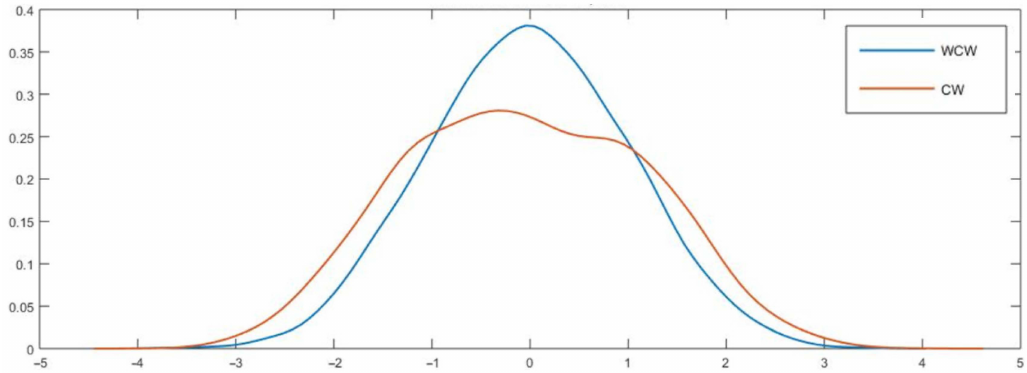
Figure 3. Kernel densities of CW and WCW under the null hypothesis, DGP2, h = 27. Note: See notes in Figure